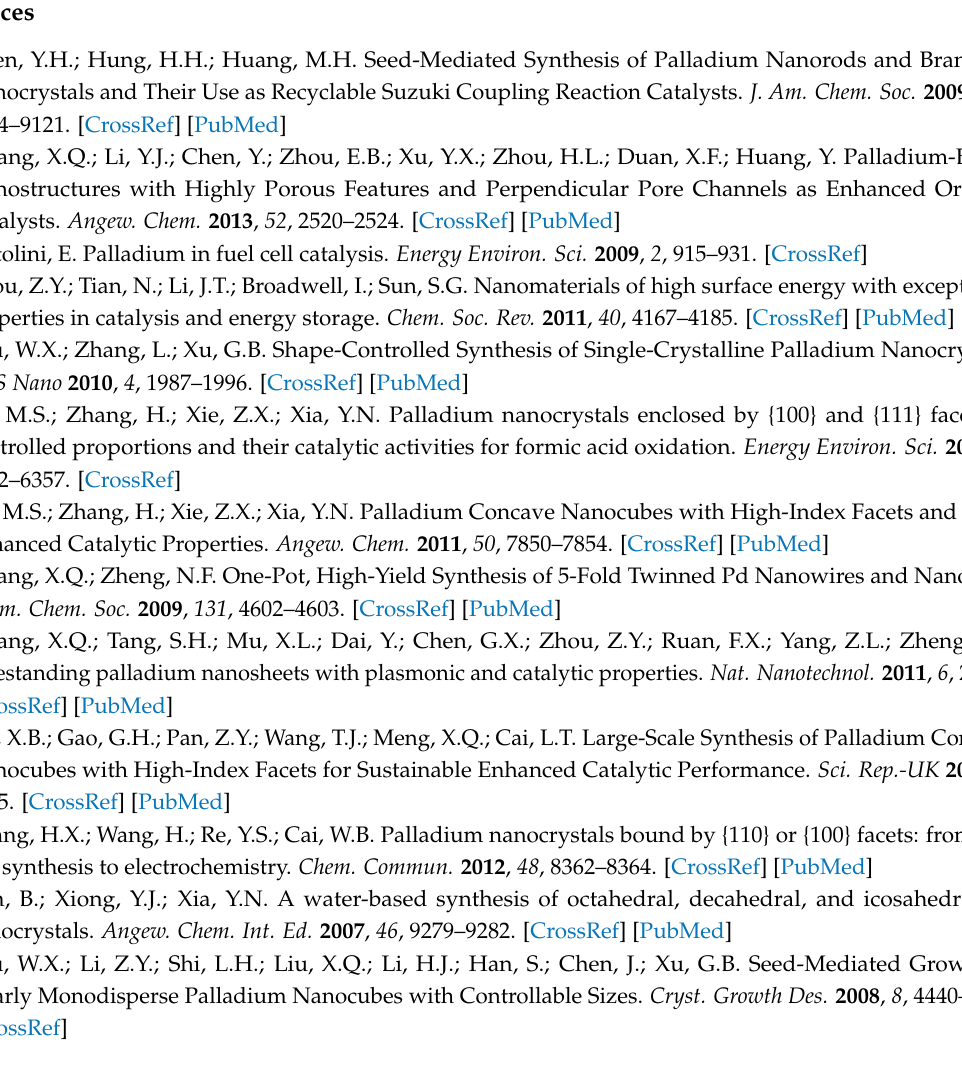
Figure S1: SEM images of Pd nanoparticles without iodide in the standard system for the synthesis of palladium nanocubes. Figure S2: SEM images of Pd nanoparticles collected from the reactions with the same conditions used in the synthesis of monodispersed Pd nanocubes (Figure 1A) but with I − replaced by (A) Cl − and (B) Br − . Figure S3: SEM images of Pd nanoparticles with different amount of sodium iodide (A) 150 mg and (B) 600 mg. Figure S4: SEM images of Pd nanoparticles with different amount of PVP (A) 250 mg and (B) 550 mg. Figure S5: SEM images of Pd nanoparticles with different reaction temperature (A) 170 ◦ C and (B) 230 ◦ C. Figure S6: Cyclic voltammograms of Pd nanoparticles recorded in 0.1 M HClO 4 . Scan rate: 50 mV s − 1 . Figure S7: Cyclic voltammograms of Pd nanocubes (the same batch of samples were treated without NaBH 4 and treated) recorded in 0.1 M HClO 4 . Scan rate: 50 mV s − 1 . Figure S8: Cyclic voltammograms of Pd nanoparticles (the same batch of samples were treated without NaBH 4 and treated) (A) Pd-Cl − NPs and (B) Pd-Br − NPs were recorded in 0.1 M HClO 4 . Scan rate: 50 mV s − 1 . Figure S9: (A) The SEM of cubic Pd nanoparticles after NaBH 4 treatments, (B) Size distribution of the cubic Pd nanoparticles after NaBH 4 treatments, (C) EDS of the cubic Pd nanoparticles after NaBH 4